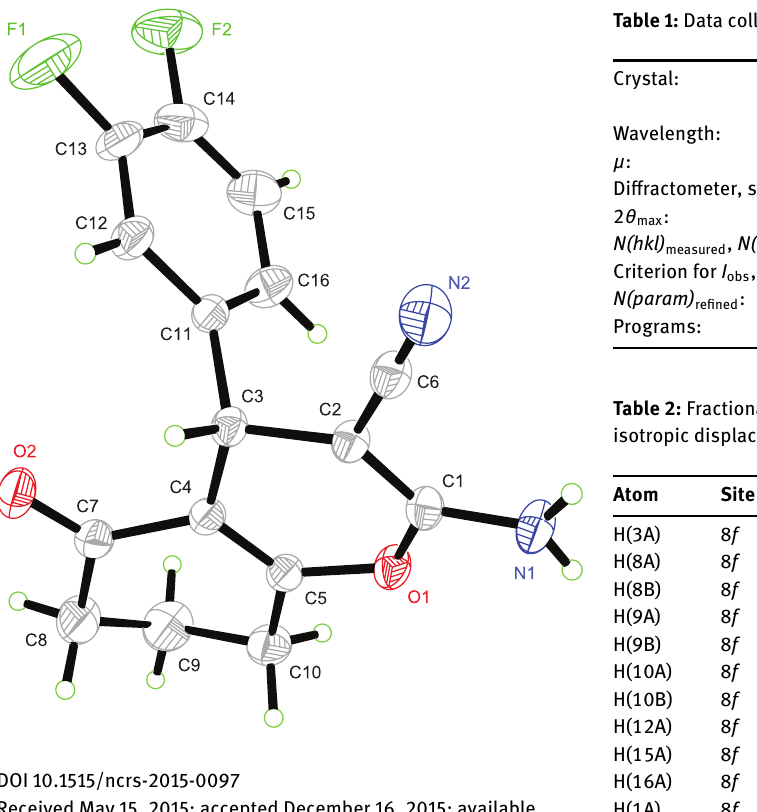
Table 1: Data collection and handling.